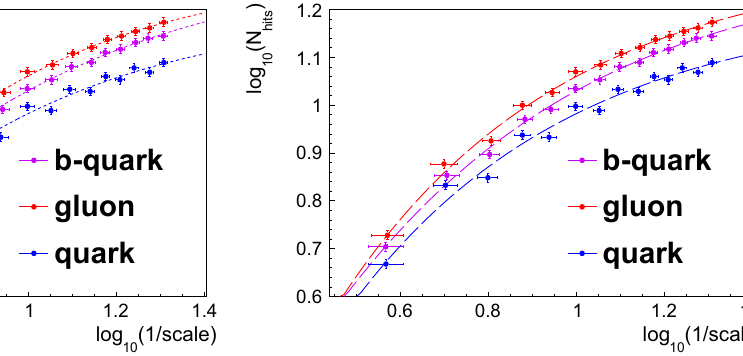
ExtendedFractalObservables.Right:fitstolog ( N hits ) againstlog ( 1 /(cid:4)) using an asymptotically saturating fitting function, specifically y =